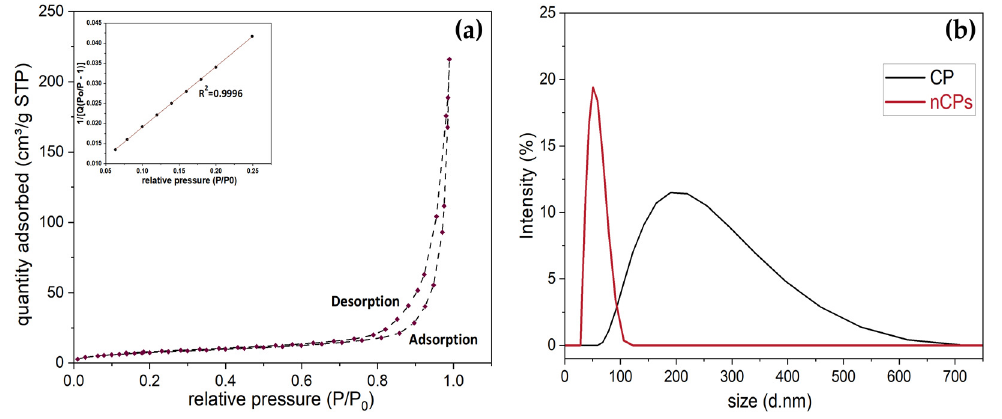
Figure 6. ( a ) BET nitrogen adsorption isotherm plot. ( b ) DLS results of CP and